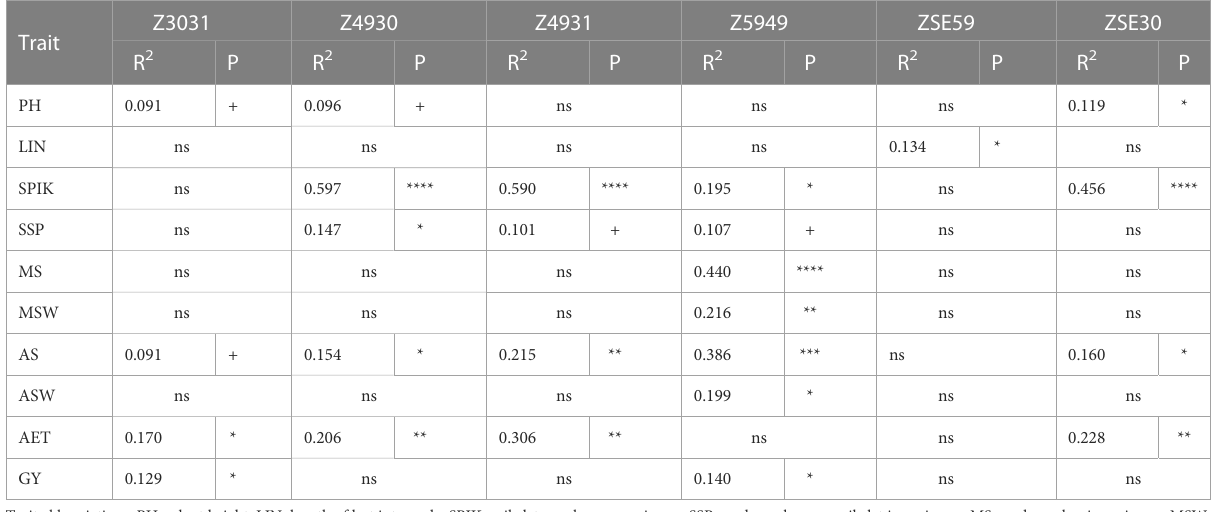
Trait abbreviations: PH, plant height; LIN, length of last internode; SPIK, spikelet number per main ear; SSP, seed number per spikelet in main ear; MS, seed number in main ear; MSW, seed weight in main ear; AS, average seed number; ASW, average seed weight; AET, average thousand kernel weight; GY, grain yield per plant. ns, not signi fi cant.